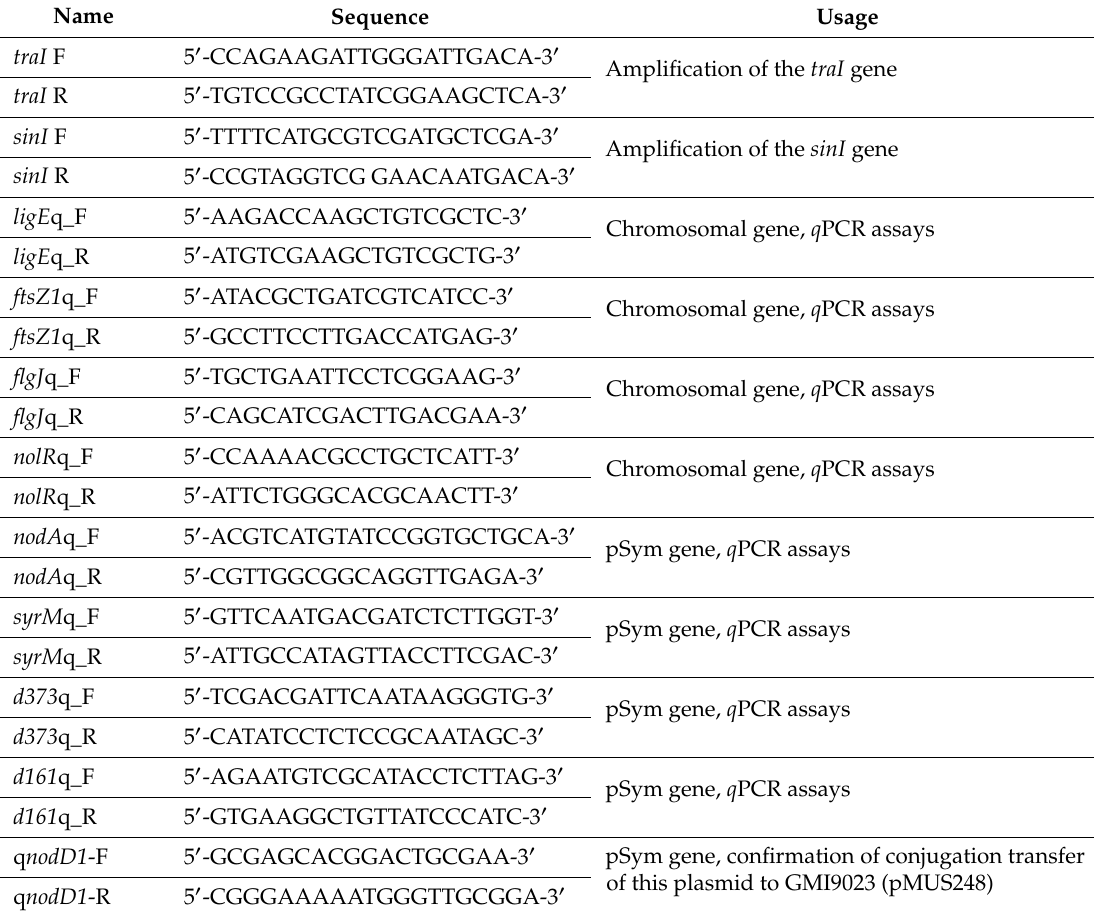
Table 2. DNA oligonucleotide primers used in this